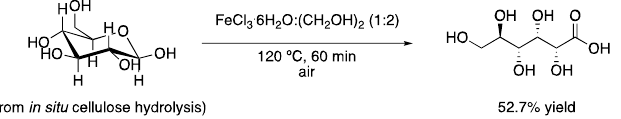
Figure 1. Hydrolysis and oxidation of cellulose to gluconic acid.